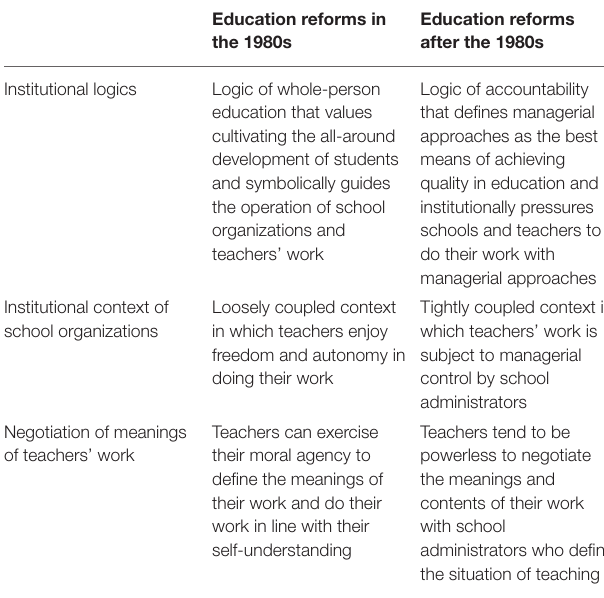
TABLE 4 | Differences in institutional logics, institutional context, and negotiation of meanings between the contexts of education reform in and after the 1980s in Hong